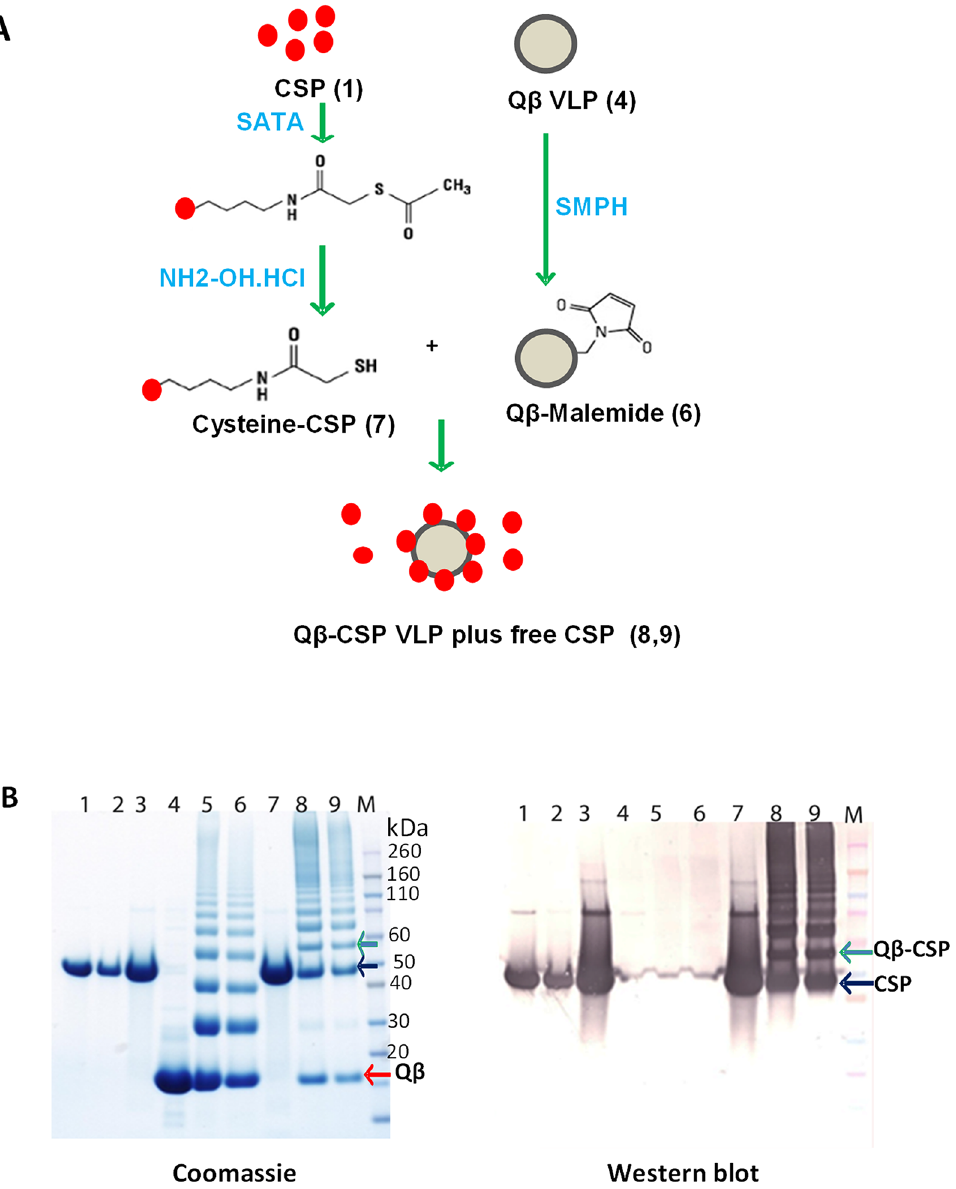
Fig 1. Production of the Q β -CSP vaccine. A, Outline of the conjugation process. Numbers in parentheses correspond to the respective lane number in Fig 1B. B, CSP and Q β proteins analyzed by reducing SDS-PAGE followed by coomassie blue staining (left) or western blot using anti-CSP polyclonal mouse antibodies (right). Lane 1, soluble CSP protein; 2, CSP diluted in urea; 3, SATA treated and desalted CSP; 4, Q β protein; 5, SMPH treated Q β ; 6, desalted Q β -Malemide; 7, deacetylated and desalted CSP; 8, CSP-Q β conjugate; 9, desalted CSP-Q β conjugate (final vaccine); M, molecular weight